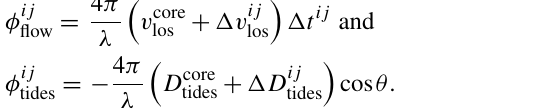
regions with different fringe rates and fringe orientations. As